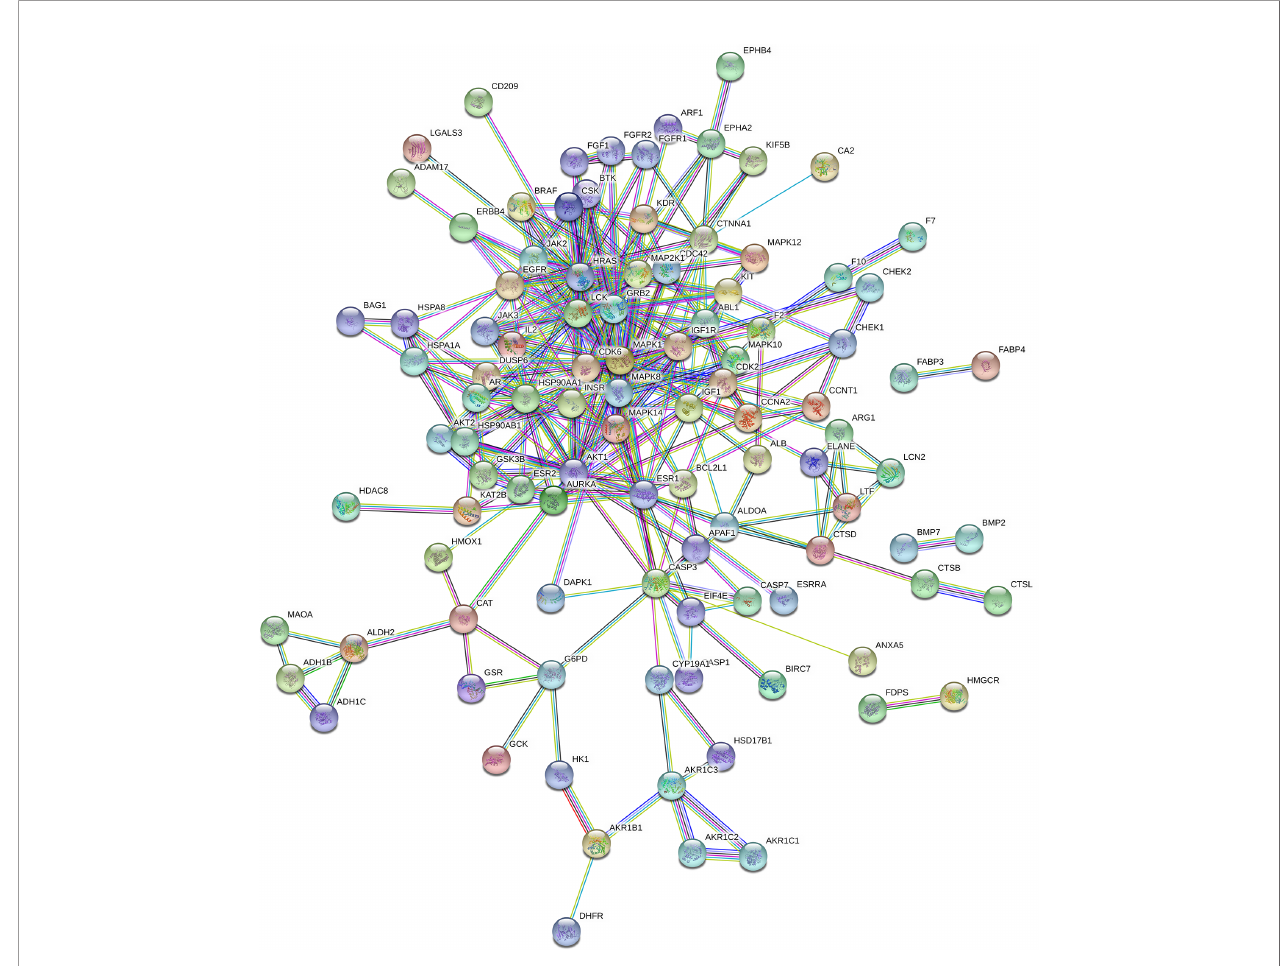
FIGURE 3 | PPI network of THSWD in treating potential targets of breast